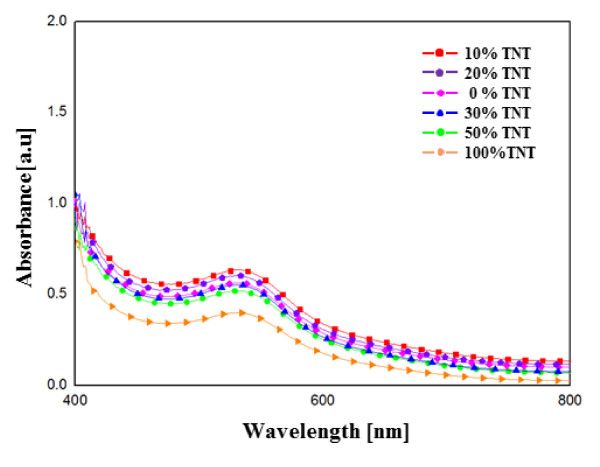
Absorption spectra of dye from TiO2 films containing different ratios of TNTs.